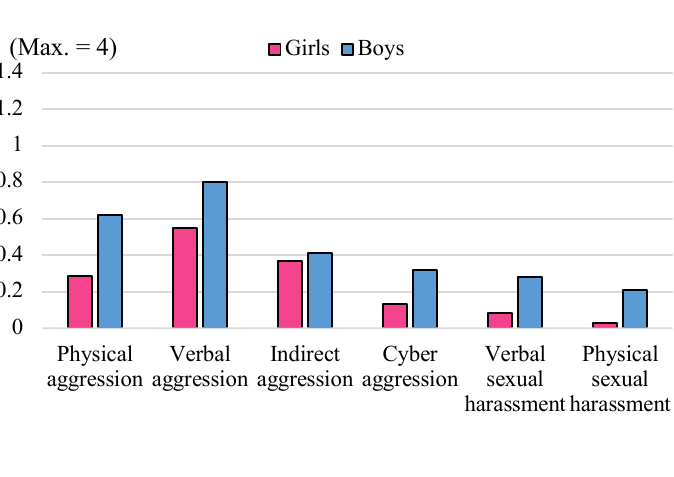
Mean scores of perpetration of six types of aggression and sexual harassment, according to sex (N = 1,597). For significant differences, cf. Table